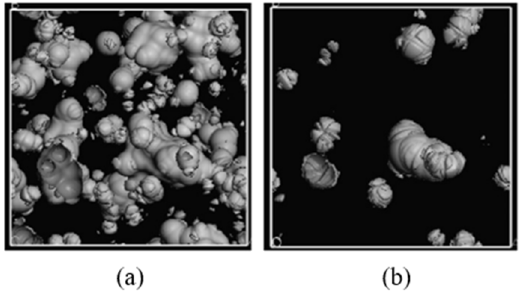
Figure 14. The free volume holes in PVA–EDTMPA-20 with water and propylene as the probes: ( a ) water; ( b ) propylene [68].